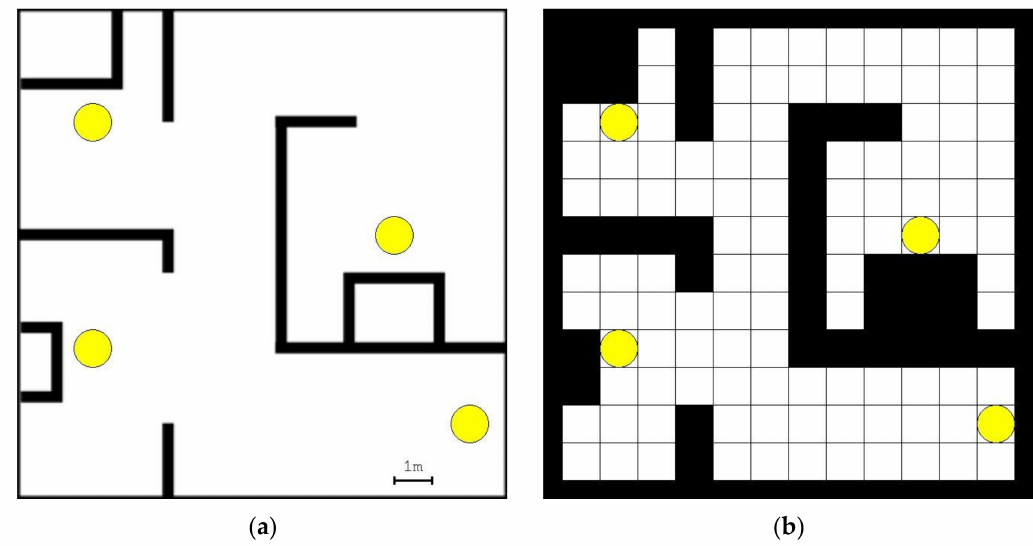
Figure 4. ( a ) Layout for the experiments and ( b ) the corresponding occupancy grid with the cell size of 1 m.